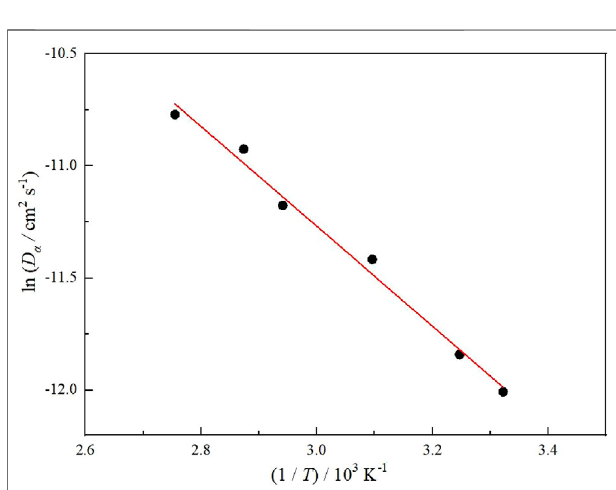
FIGURE 8 | Effect of temperature on hydrogen diffusivity of carbon steel in temperature range from 298 to 373 K